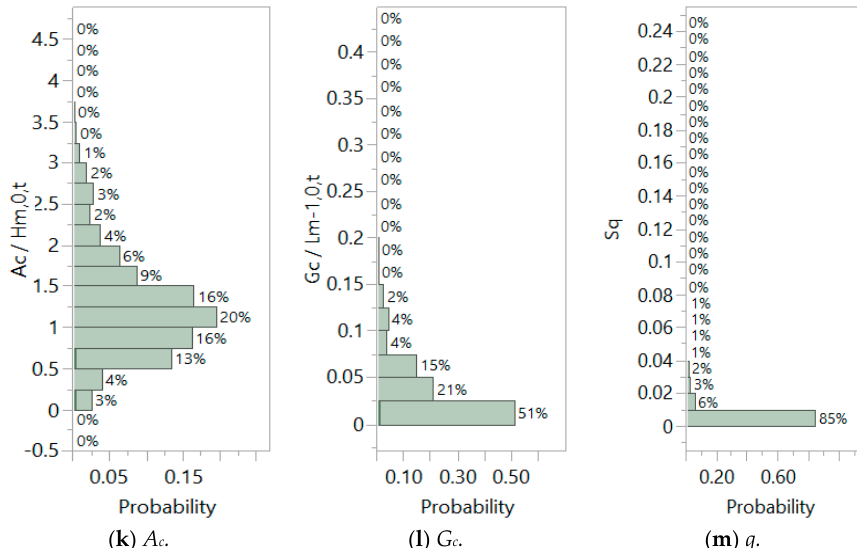
Figure 5. Parameter spectrum of the assembled database.